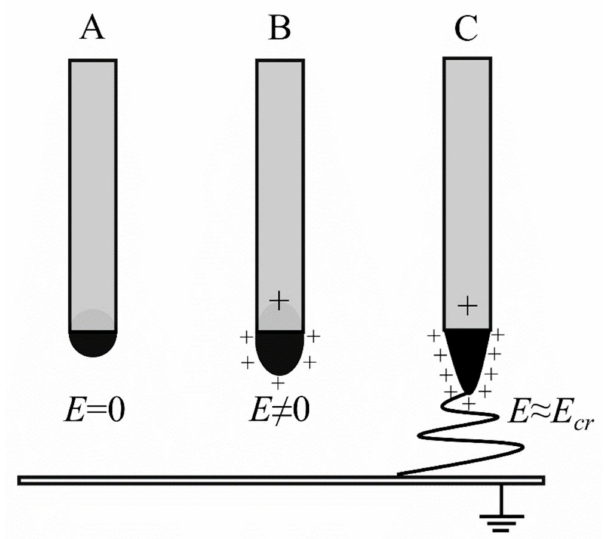
Figure 3. Schematic illustration of Taylor cone formation (( A )—a stable droplet of polymer solution with no electric field, ( B )—a distorted droplet of polymer solution in the presence of an electric field, ( C )—formation of nanofiber from Taylor cone for an electric field of critical value) (own elaboration). Due to the influence of an electric field, this jet moves towards a grounded